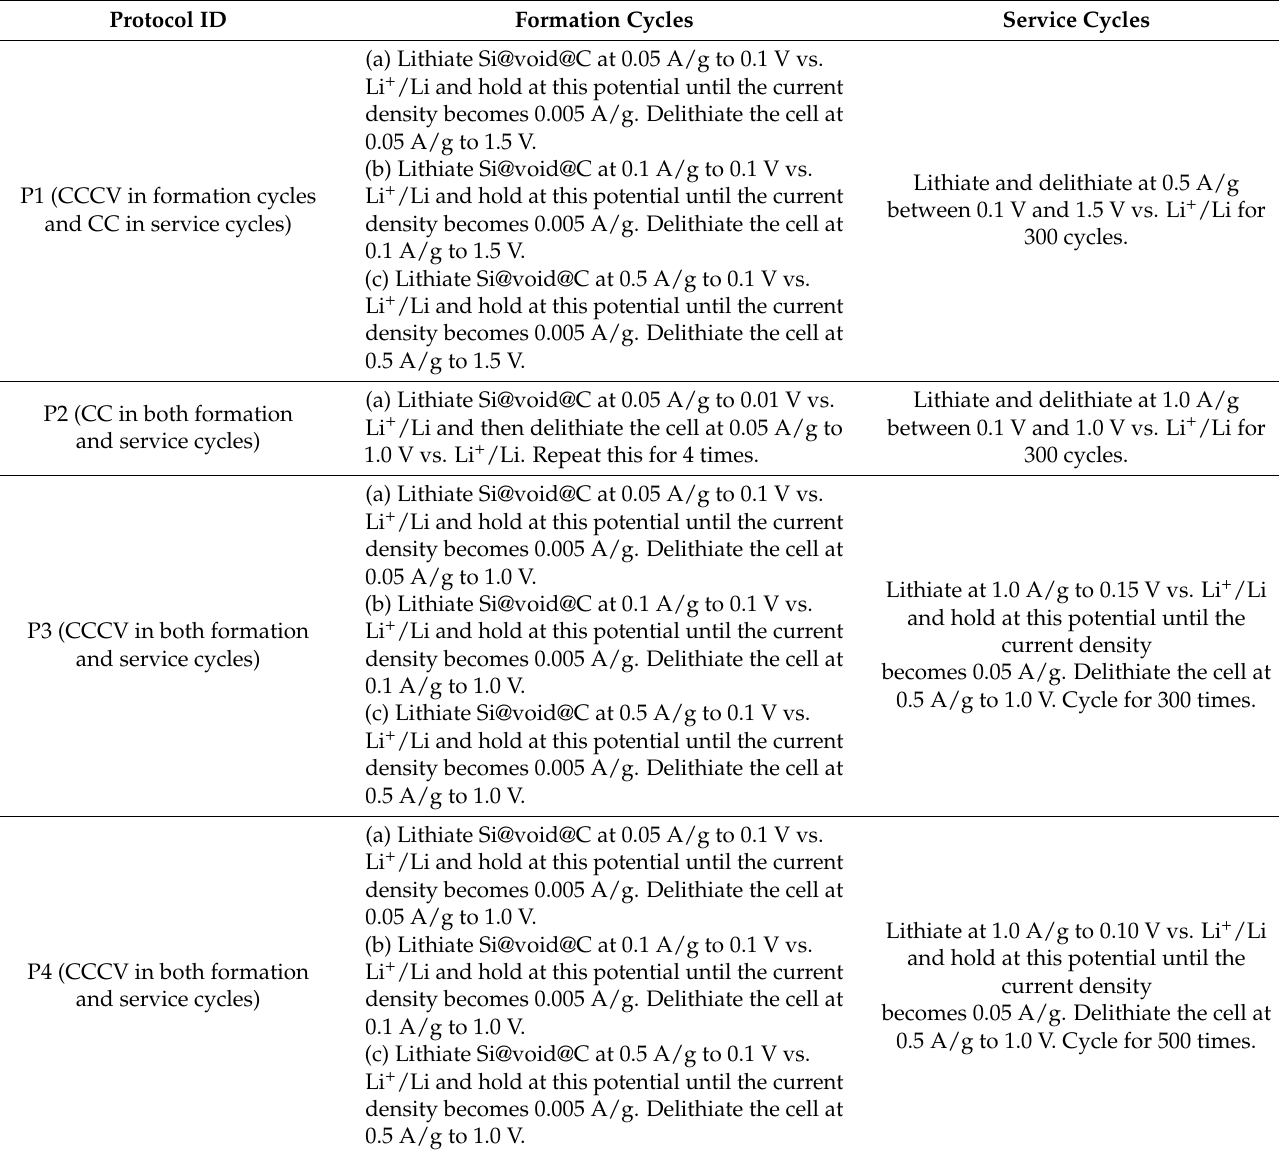
Table 3. Charge/discharge protocols